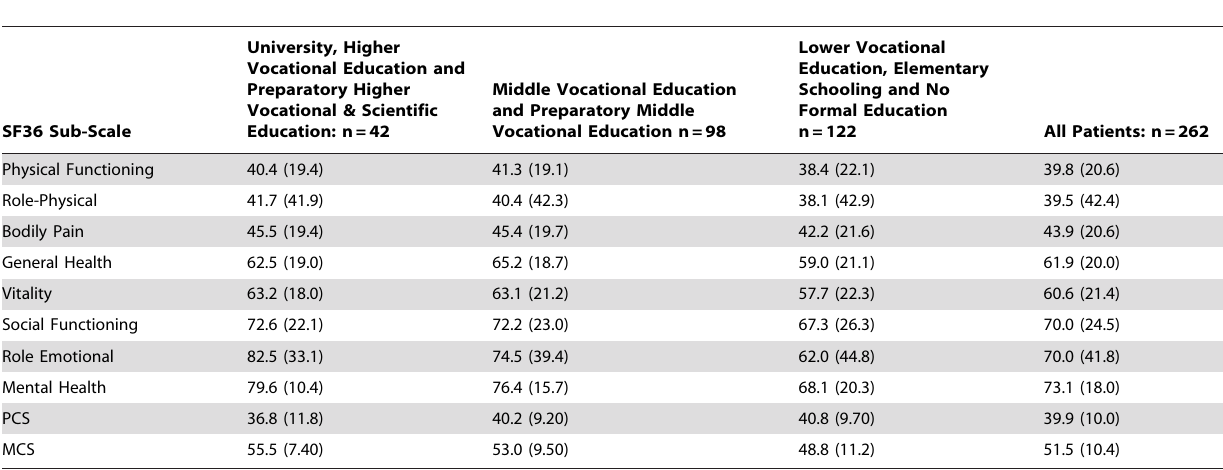
Table 3. Quality of Life before Knee Replacement: A Comparison Between Patients with different Completed Levels of Schooling.